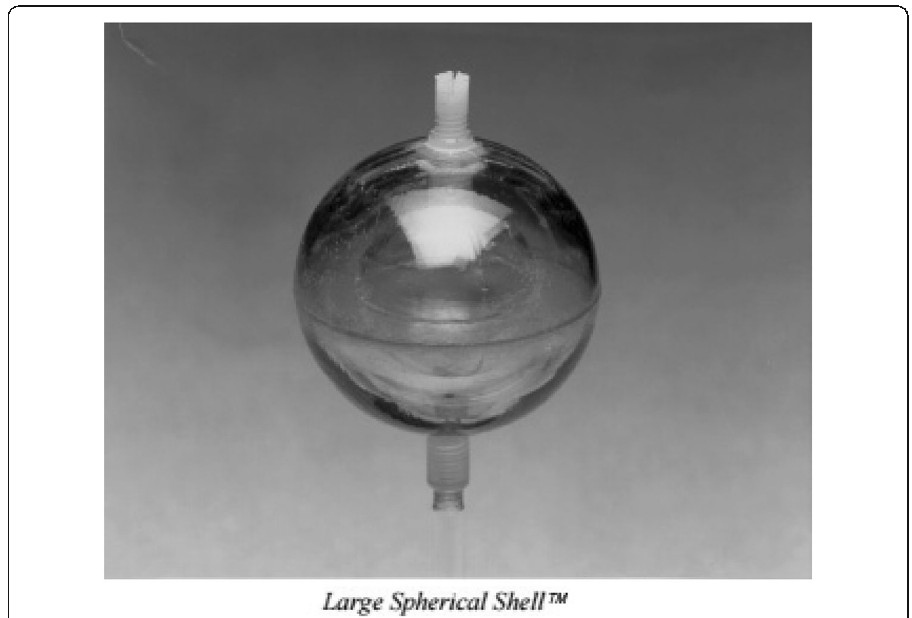
Fig. 2 The DSC large spherical shell used in the comparison